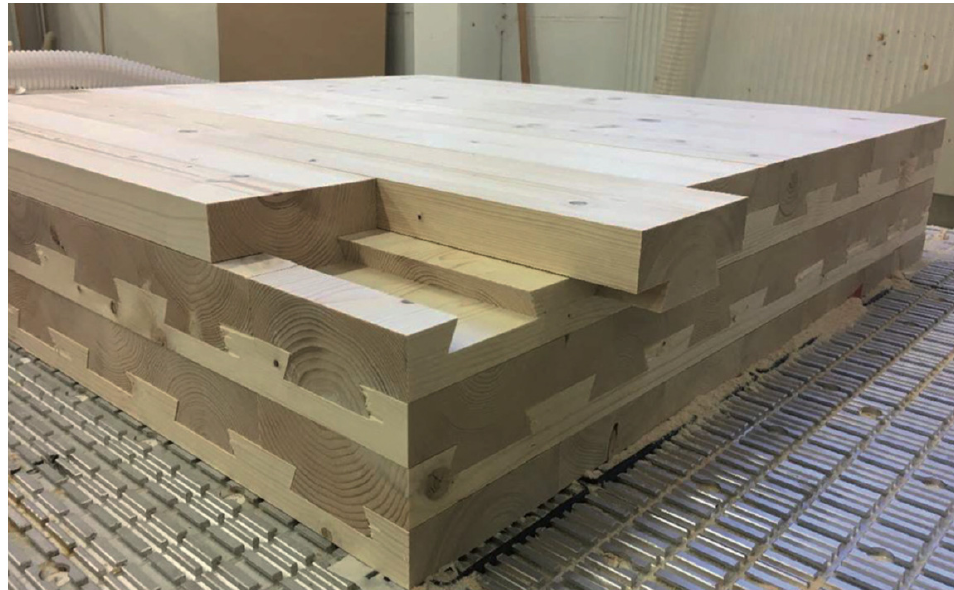
Figure 18. Prototype of a dovetailed wooden panel [133,134].